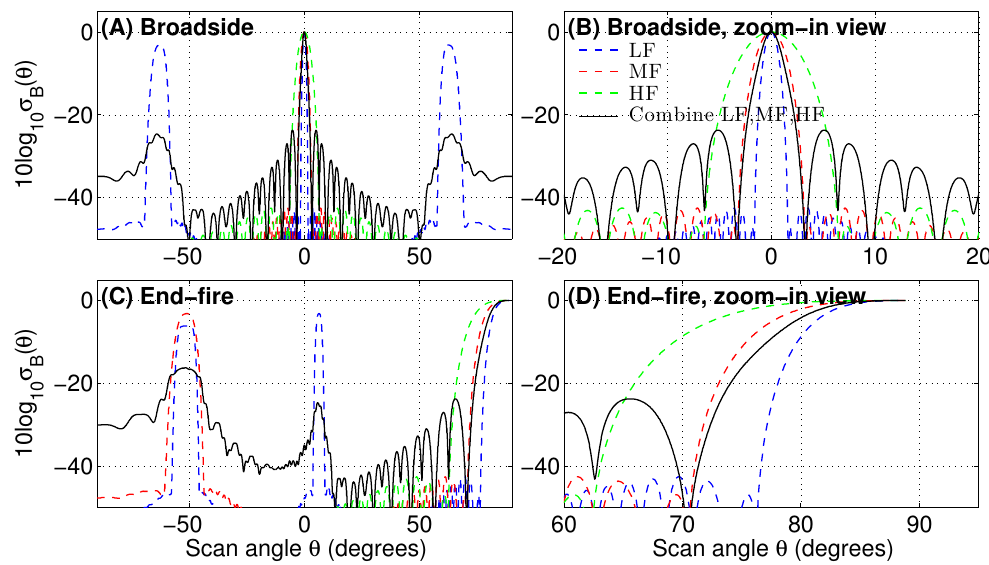
Figure 4. The time-averaged beamformed intensity σ B ( θ ) calculated via Equation (8) corresponding to Figure 3 for a broadband linear frequency modulated (LFM) pulse signal of 50 Hz bandwidth centered at 1125 Hz with a uniform normalized power spectral density. The continuous frequency integrals are implemented as discrete frequency component summation with a frequency increment d f = 0.1 Hz. The incident signal is assumed to be in the direction of ( A , B ) array broadside ( θ 0 = 0) and ( C , D ) array end-fire ( θ 0 = 90 ◦ ), respectively. The beam width of the nonuniformly-spaced subarray is approximately three times smaller than that of the conventional HF subaperture at broadside, and approximately 1.7 times smaller at